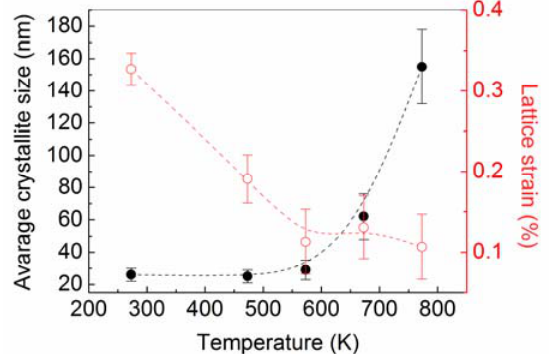
Figure 8. Average crystallite size (full symbols) and lattice strain (open symbols) for the hcp Mg phase in the Mg-7.4%Al powder milled at RT for 100 h followed by 3 h of cryo-milling as a function of the annealing